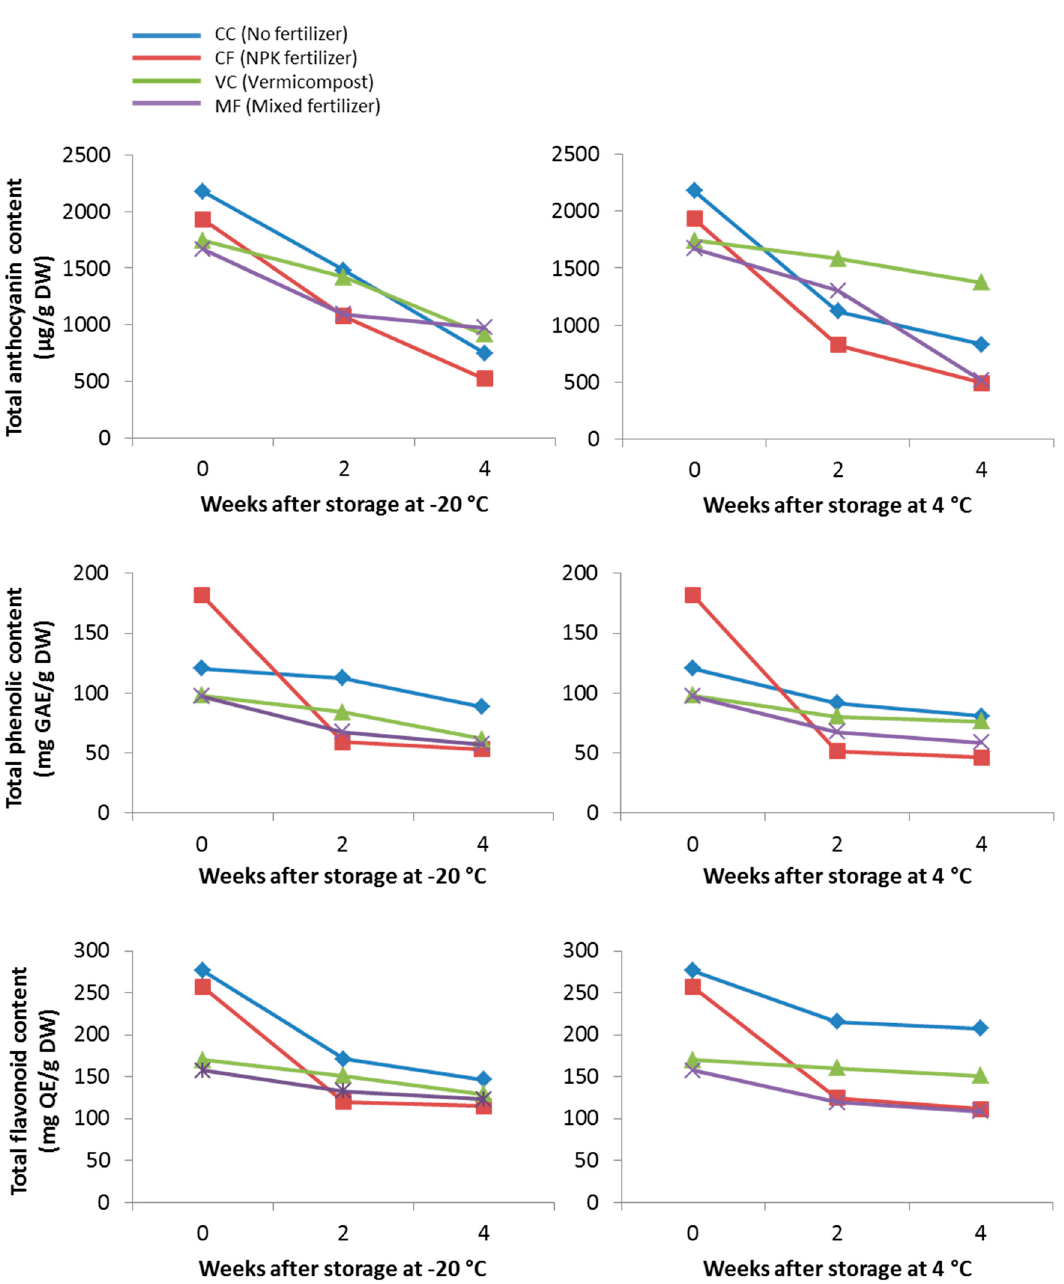
Figure 1. Effect of extract storage at − 20 °C and 4 °C on total anthocyanin (TAC), total phenolic (TPC), and total flavonoid (TFC) contents in the methanolic extracts of C. nutans supplemented with different fertilizers.